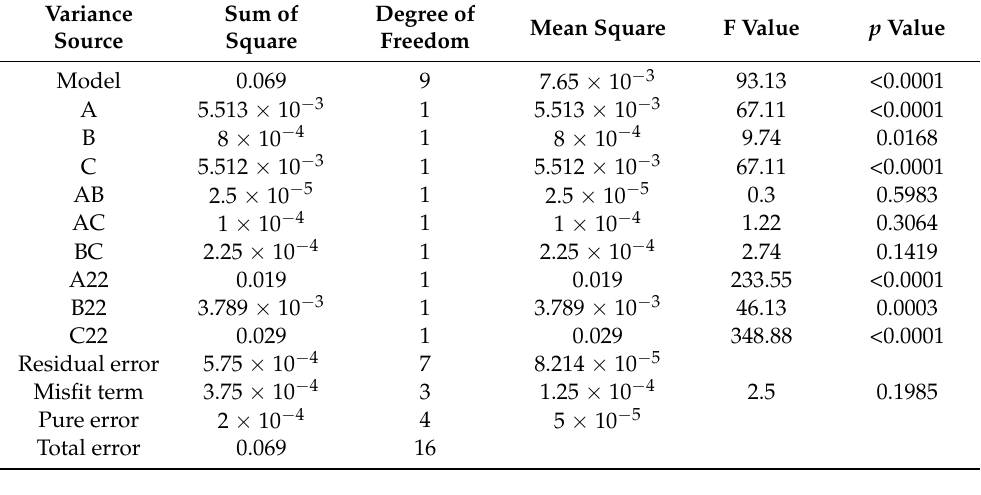
Table 4. The results of the analysis of variance.